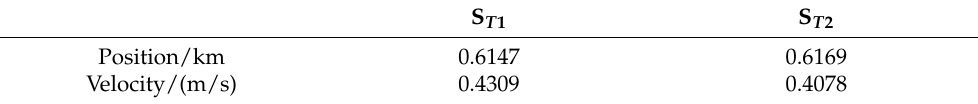
Figure 8. Time history of the RMSEs considering invisible arcs. Table 5. Mean RMSE of the Monte Carlo simulation considering invisible